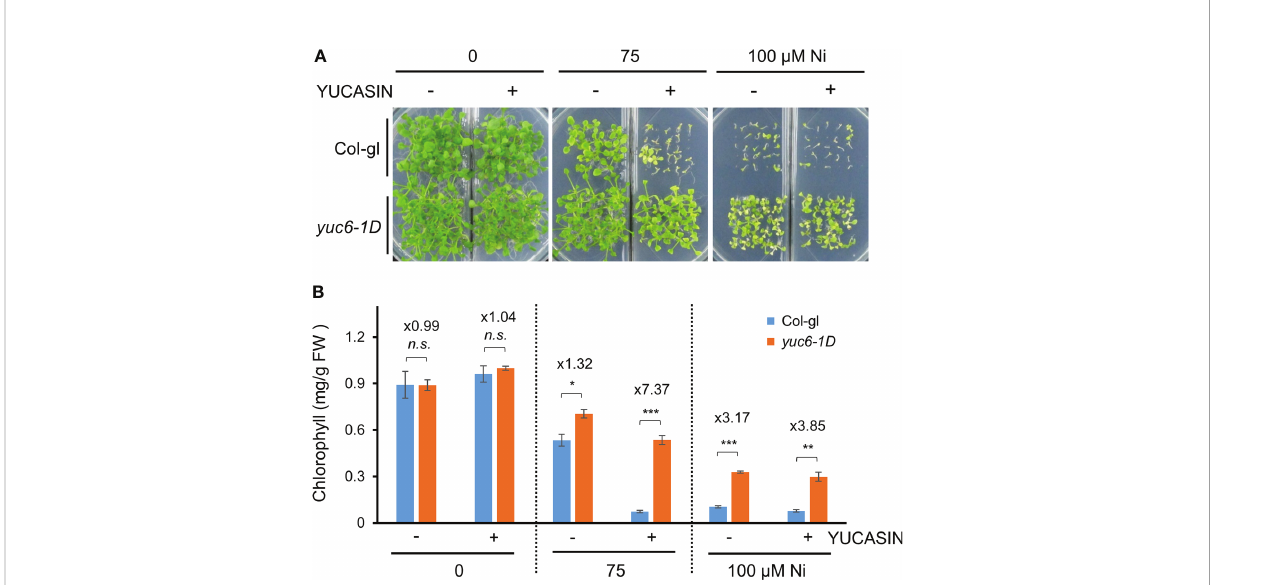
FIGURE 4 The yuc6-1D mutant displays Ni stress tolerance independent of IAA biosynthesis. Phenotypes (A) and chlorophyll contents (B) of Col-gl WT and yuc6-1D plants grown in 0, 75, or 100 m M Ni-containing media in the absence or presence of 125 µM YUCASIN. Values are means ± SE of three independent biological replicates. Asterisks indicate signi fi cant differences (* p < 0.05, ** p < 0.01, *** p < 0.001, and n.s. , no signi fi cant) from the WT determined using two-tailed Student ’ s t -test. The numbers above the bars indicate the ratio of chlorophyll contents of WT and yuc6-1D (Col-gl and yuc6-1D